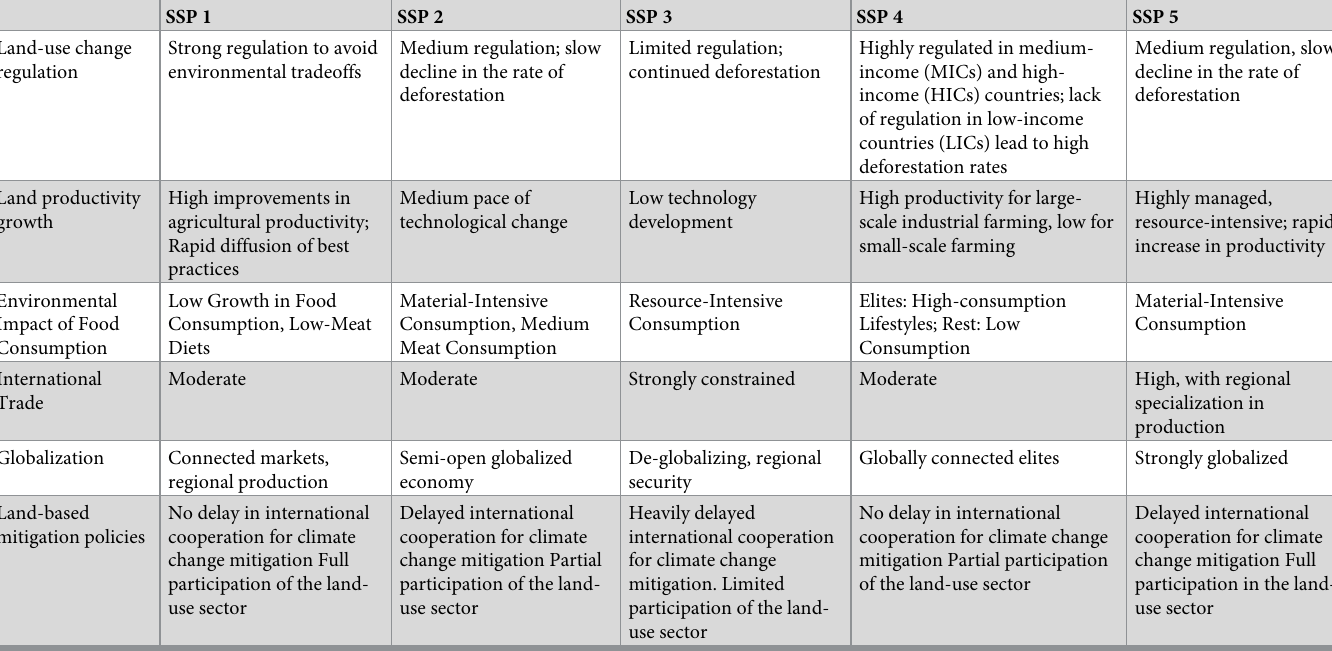
Table 2. Synthesis of core premises differentiating the SSPs in relation to land use. Source: Popp et al. [29]. SSP 1